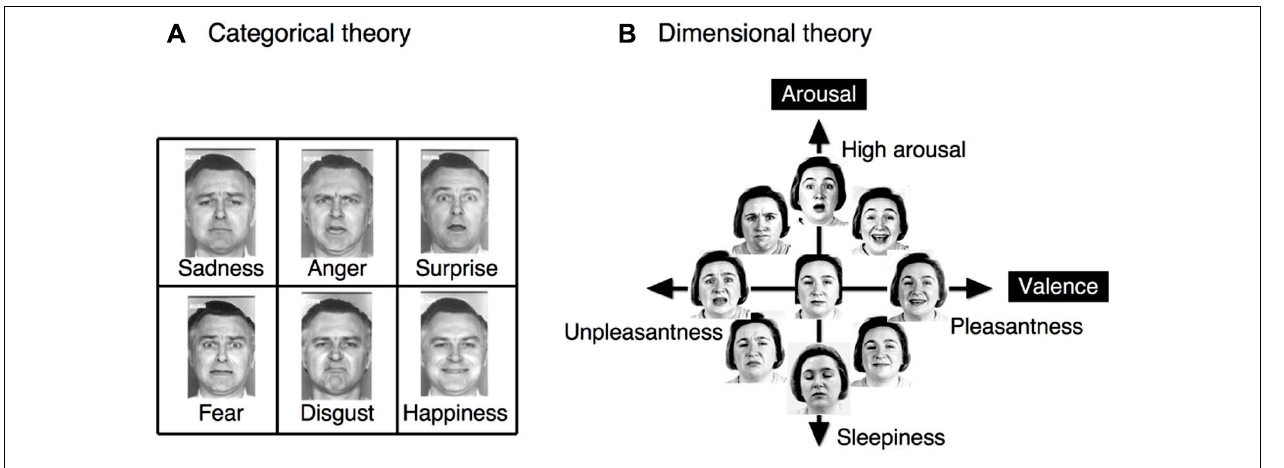
FIGURE 1 |The two different theories regarding facial emotion perception. (A) The categorical theory proposes the existence of six basic, distinct and universal emotions, with clear boundaries separating emotional states. (B) The dimensional theory proposes the existence of the